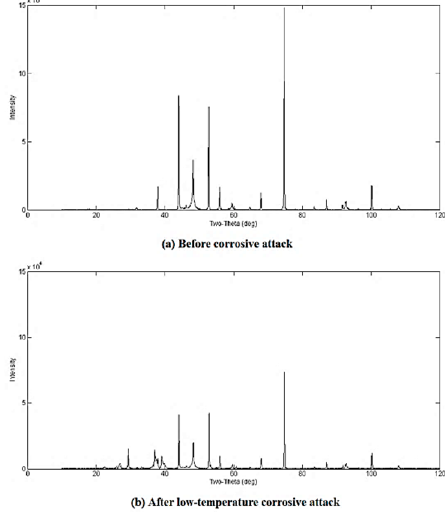
Figure A25. Qualitative XRD analysis of the surface of CS-B ( a ) before corrosive attack, ( b ) after low-temperature corrosive attack.